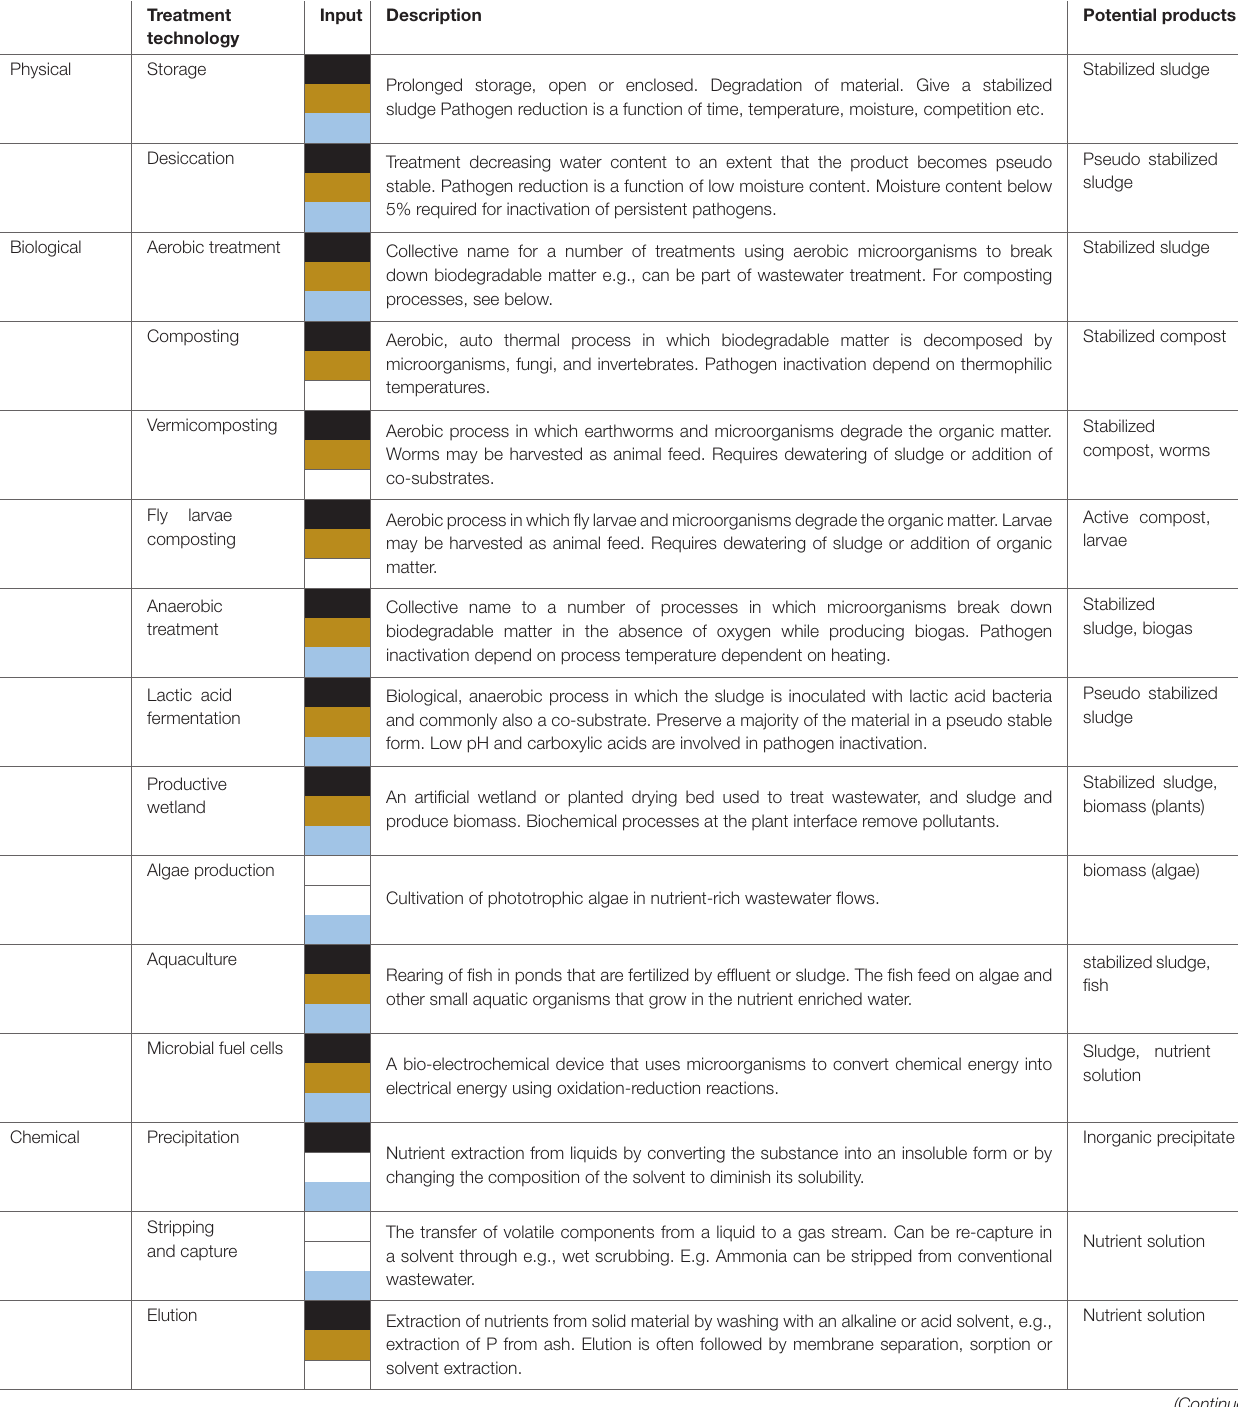
TABLE 1 | Summary of possible treatment technologies for nutrient-recovery from fecal sludge, based on recent review studies that map a variety of treatment processes and products (Harder et al., 2019; Johannesdottir S. et al., 2019). Treatment